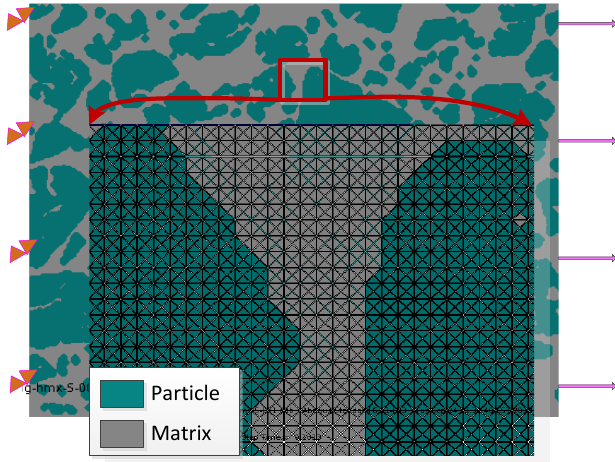
Figure 12. Boundary and loading conditions and detail meshes of the finite element (FE) model.